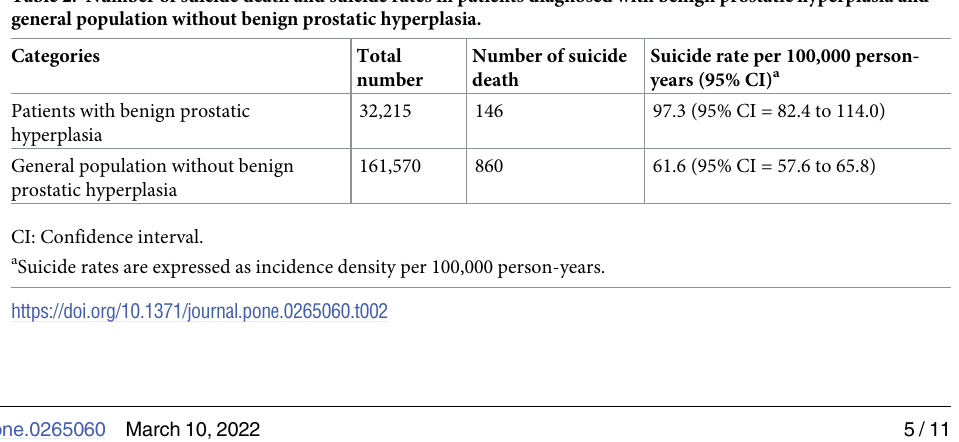
The cox-proportional hazard model was used to examine the hazard ratio for suicide among patients with BPH compared to general population without BPH after adjusting for covariates (Table 3). In the unadjusted model, hazard ratio (HR) for suicide among patients with BPH